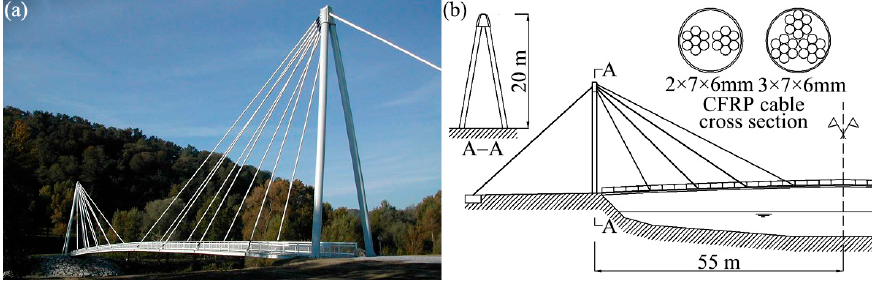
Figure 15. Laroin CFRP Footbridge, ( a ) photo (photo credit: Freyssinet) and ( b ) sketch.